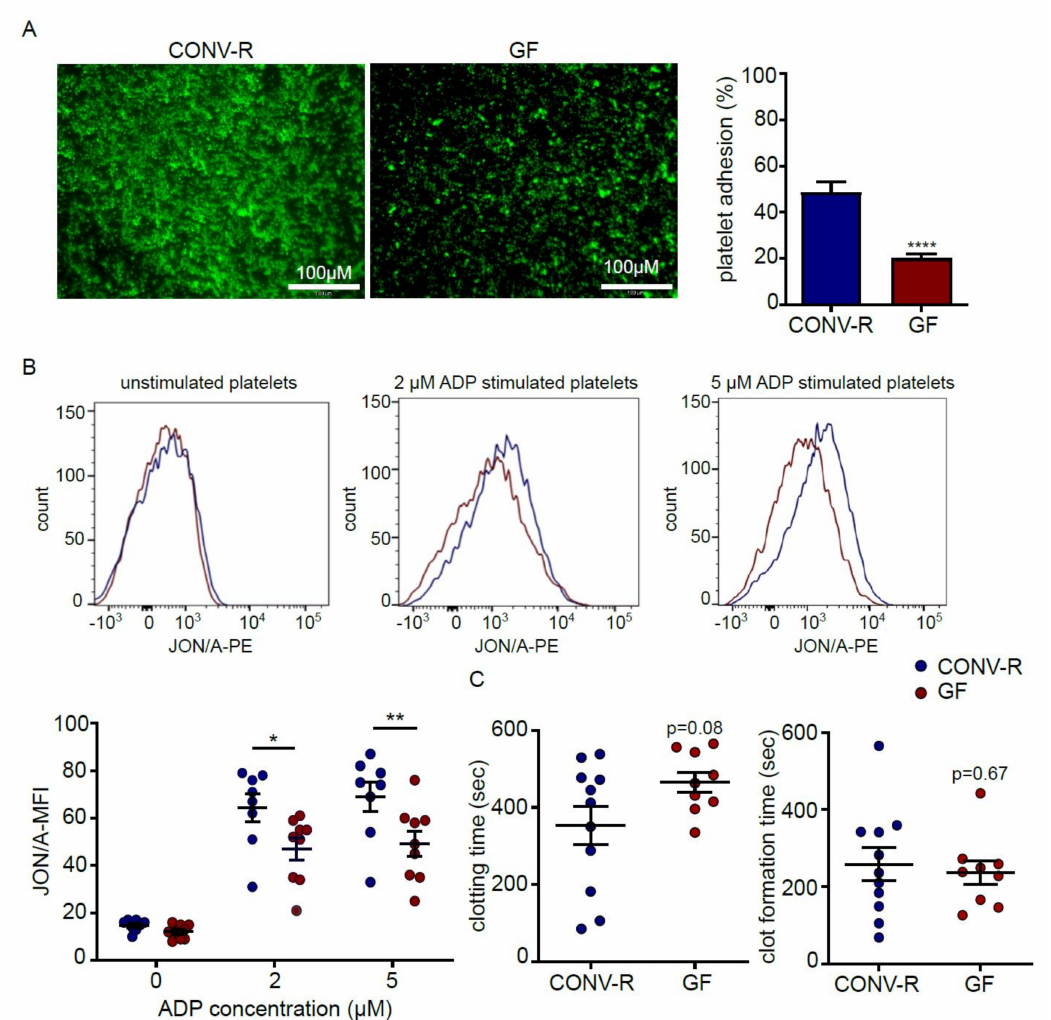
Figure 1. Reduced deposition of germ-free (GF) mouse platelets to type I collagen coatings is paralleled by diminished ADP-triggered integrin α IIb β 3 activation. ( A ) Representative images and bar graph of platelet deposition from GF (red) and conventionally raised (CONV-R) (blue) mice on type I collagen-coated slides ( n = 13) ( B ) Flow cytometry analysis of platelets from GF (red) vs CONV-R (blue) mice stimulated with 0, 2 or 5 µ M ADP and stained with the phytoerythrin (PE)-conjugated JON / A antibody, recognizing activated integrin α IIb β 3 ; representative histograms and MFI (mean fluorescence intensity) quantifications ( n = 9, 8). ( C ) Comparative analysis of clotting time (CT) and clot formation time (CFT) in collagen-stimulated whole blood (8 µ g / mL) from GF and CONV-R mice ( n = 9, 11). All data are expressed as means ± SEM. Statistical comparisons were performed using the Student’s t -test and two-way ANOVA. * p < 0.05, ** p < 0.01, **** p <